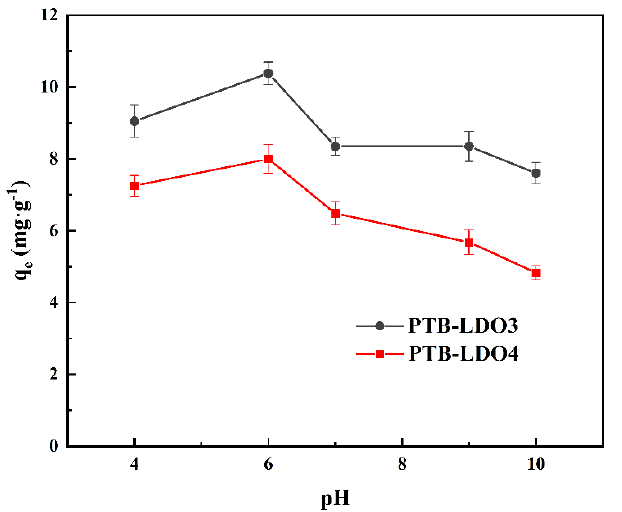
Figure 5. Effect of initial pH of PTB-LDO3 and PTB-LDO4 (solution: 10 mg L −1 , 0.40 g L −1 dosages, 6 h).